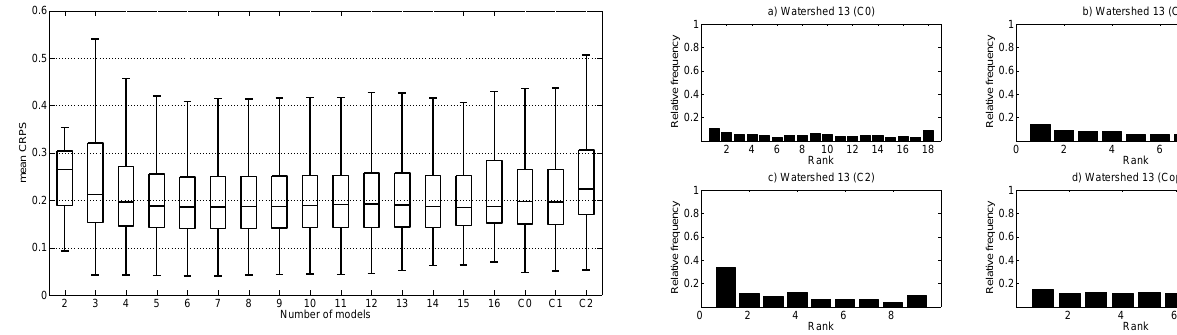
Fig. 15. Examples of rank histograms for a given catchment with ensembles C0, C1, C2 and the optimized subset